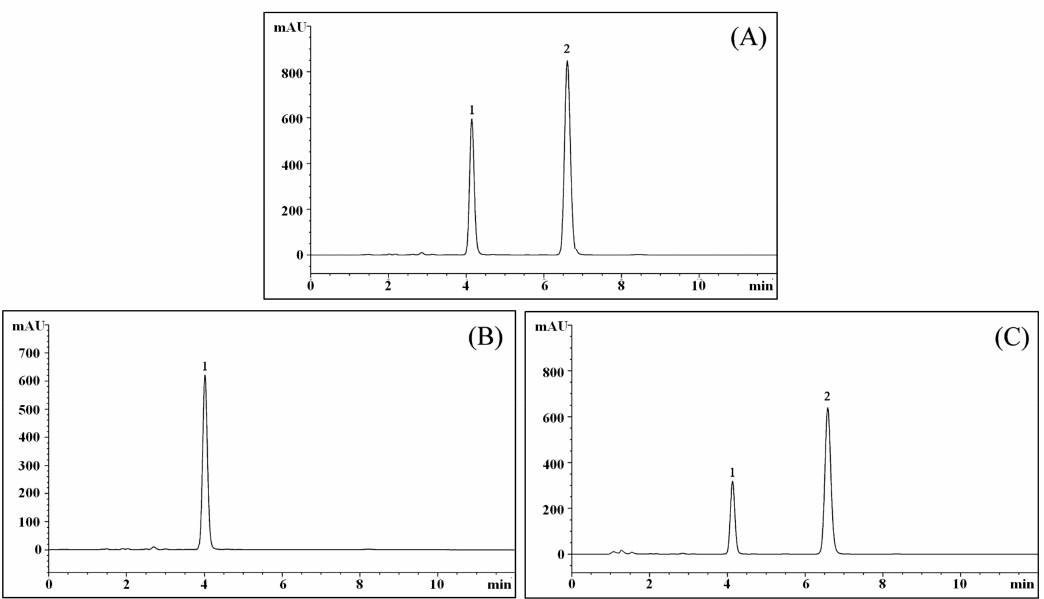
Figure 11. Chromatograms of geniposide and genipin. ( A ) Chromatogram of geniposide and genipin standards; ( B ) Chromatogram of the geniposide solution; ( C ) Chromatogram of LC-Qian-treated geniposide solution; 1: geniposide; 2: